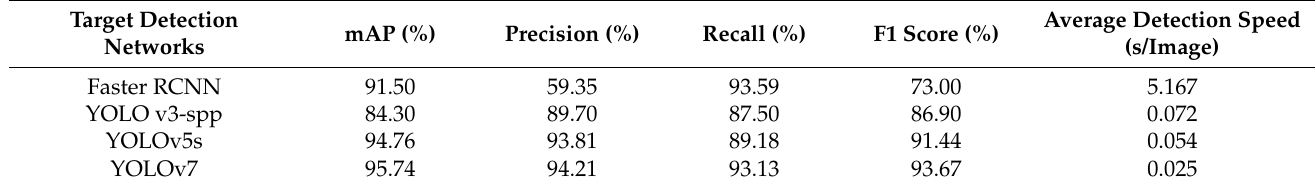
Table 1. Performance comparison among different